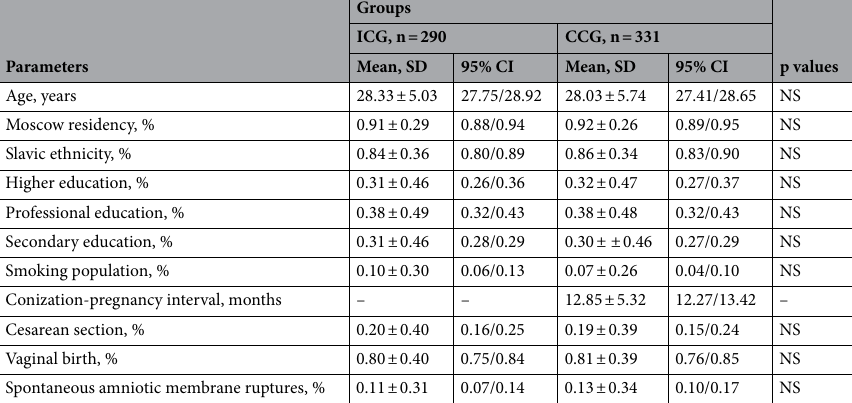
Table 1. Demographic, obstetric, and pregnancy outcome parameters with values of mean and standard deviation (SD), 95% lower/upper confidential intervals (CI) of the mean in the 1st cohort: Intact Cervix (ICG) vs Cervical Conization (CCG), groups. p-values were achieved using the Mann–Whitney two-tailed t-test with Alpha =